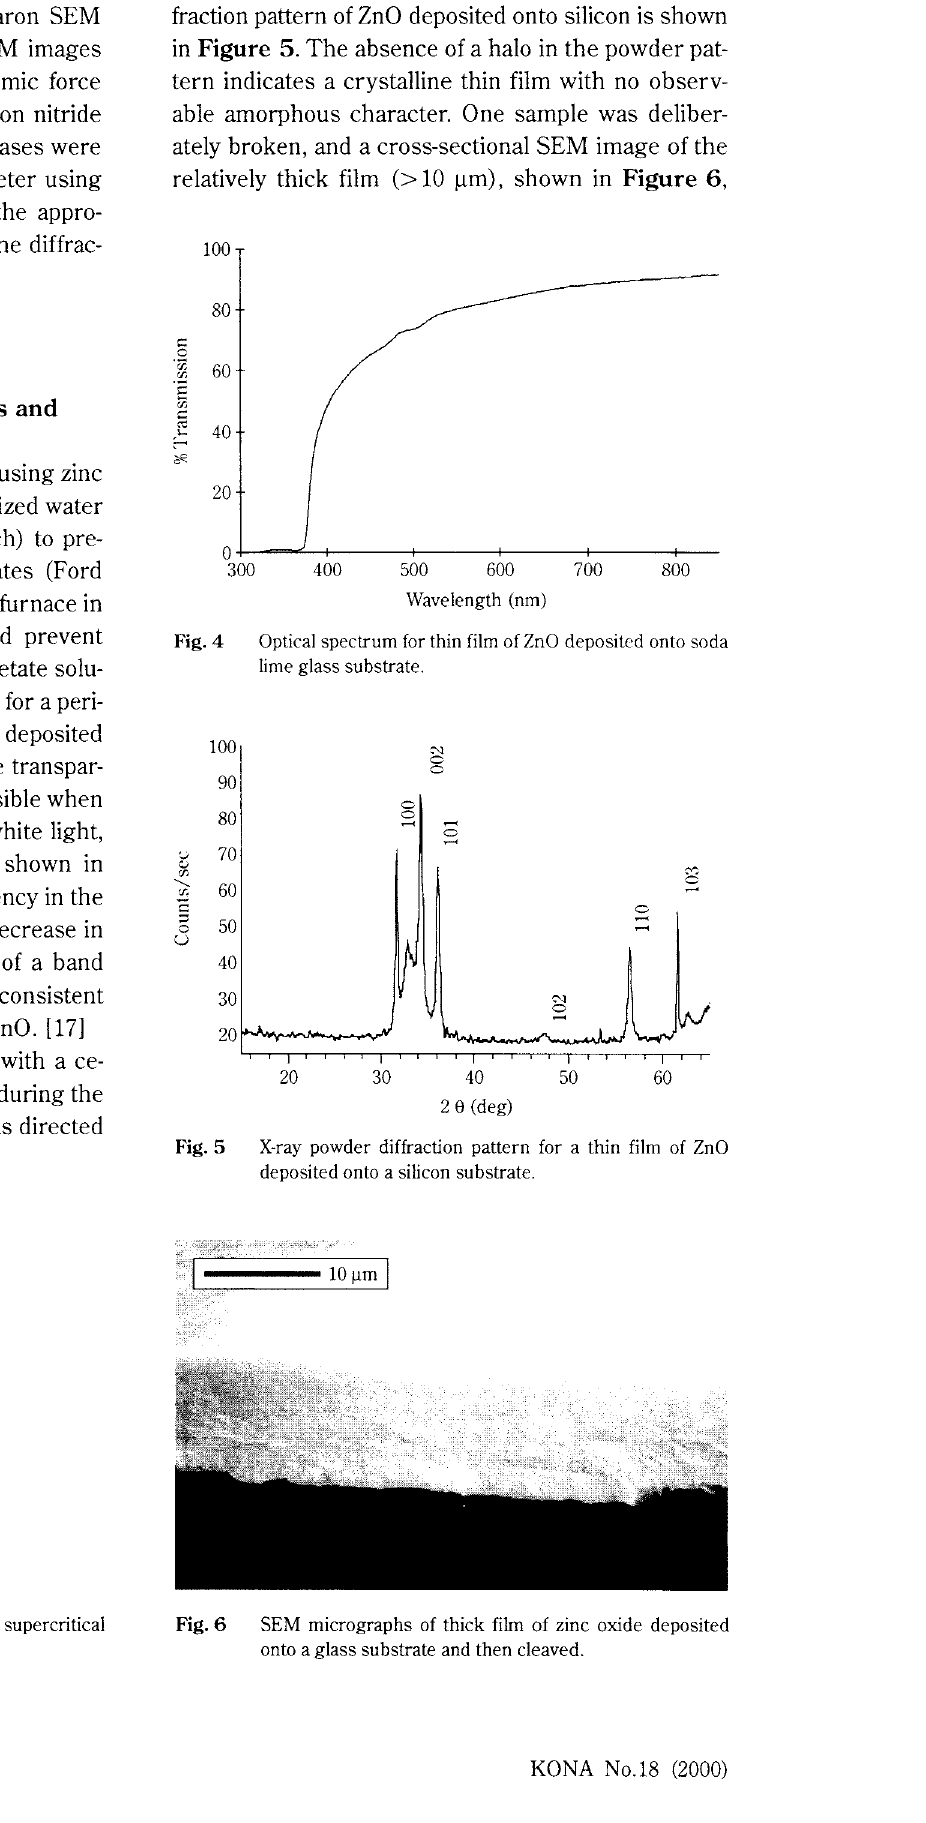
Fig. 3 Thin film of ZnO deposited on glass using supercritical C0 2 -assisted aerosolization and pyrolysis.